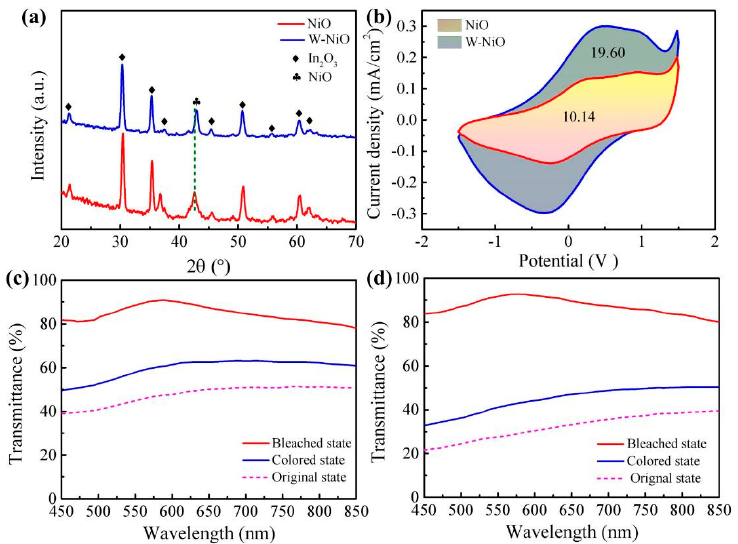
Figure 3. ( a ) XRD patterns. ( b ) CV curves of the NiO and W-NiO films. ( c ) Transmittance spectra of NiO film. ( d ) Transmittance spectra of W-NiO film. XPS measurement is carried out to analyze the composition and chemical state of the element of the NiO and W-NiO films, as shown in Figures S1 and S2. The spectra of the two samples show that the NiO film contains Ni, O, and C, while W-NiO additionally contains W with a peak at around 35.8 eV corresponding to W 4f. Ni 2p 3/2 and W 4f XPS high-resolution spectra of the W-NiO film are presented in Figure S2. The binding energy at 855.5 eV is assigned to the Ni 2p 3/2 peak with a satellite peak at 862.2 eV. The Ni 2p 3/2 peak can be fitted to two peaks corresponding to two valence states of Ni, which are Ni 2+ in Ni-O bonds and Ni 3+ mainly in Ni 2 O 3 , respectively, as shown in Figure S2a. It can be seen that Ni in the as-prepared W-NiO is mainly Ni 2+ [30]. The W 4f XPS high-resolution spectra can be fitted to W4f 7/2 and W4f 5/2 components, with the binding energies of 34.3 and 36.4 eV, respectively [31]. The results show that the W in the W-NiO film is mainly W 6+ with a proportion of 75.3%. 3.1.2. EC Performances of NiO and W-Doped NiO Films Figure 3b presents the CV curves of the NiO and W-NiO films performed at a scan rate of 50 mV/s. Both the films show obvious redox peaks corresponding to the conversion of Ni 2+ and Ni 3+ in the films, which is accompanied by the changes of colored and bleached states of the films. Compared with the NiO film, the W-NiO film exhibits larger current density, and the charge density obtained by integrating the current density is 19.6 mC/cm 2 , which is almost twice as much as that of NiO, indicating that W doping is conducive to improve the activity of the EC reaction of NiO. Due to the large difference between the stable valence states of Ni (2+) and W (6+ and 5+), the W ions of high oxidation state (6+ and 5+) will cause a large disturbance in the lattice around the W cation inserted into the Ni site. Thus, the crystal structure of NiO becomes less dense compared with pure NiO, which will lead to a large number of lattice boundaries, producing more lattice defects and active sites for the electrochromic reaction. The EC performances of the films are measured, and the transmittance spectra of the NiO and W-NiO films are displayed in Figure 3c,d. The as-prepared W-NiO film shows a low transmittance in original state, which is about 20% lower than that of NiO. When the